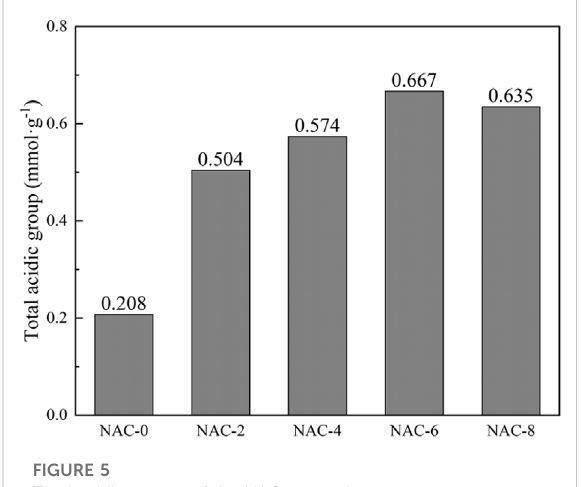
FIGURE 7 Formaldehyde dynamic adsorption capacity of AC samples before and after modi fi